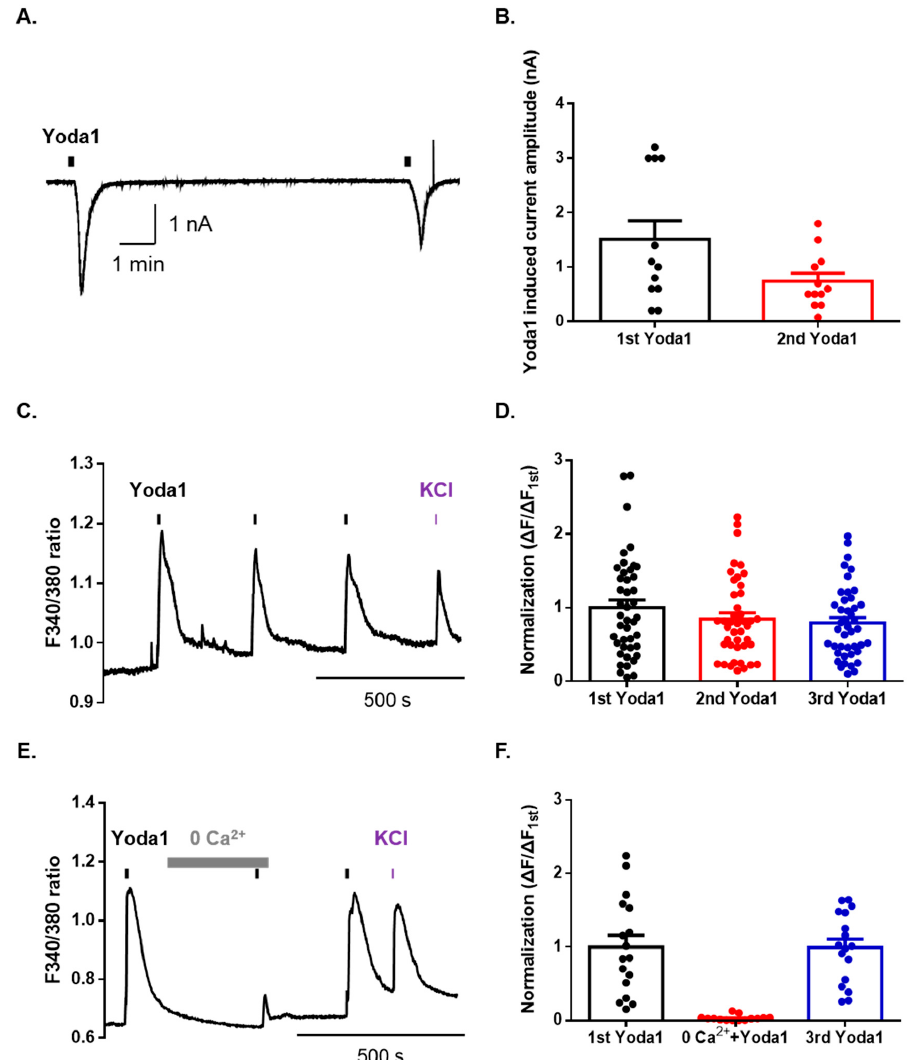
Figure 1. Yoda1 induces extracellular cation influx via Piezo1 in mouse dorsal root ganglion